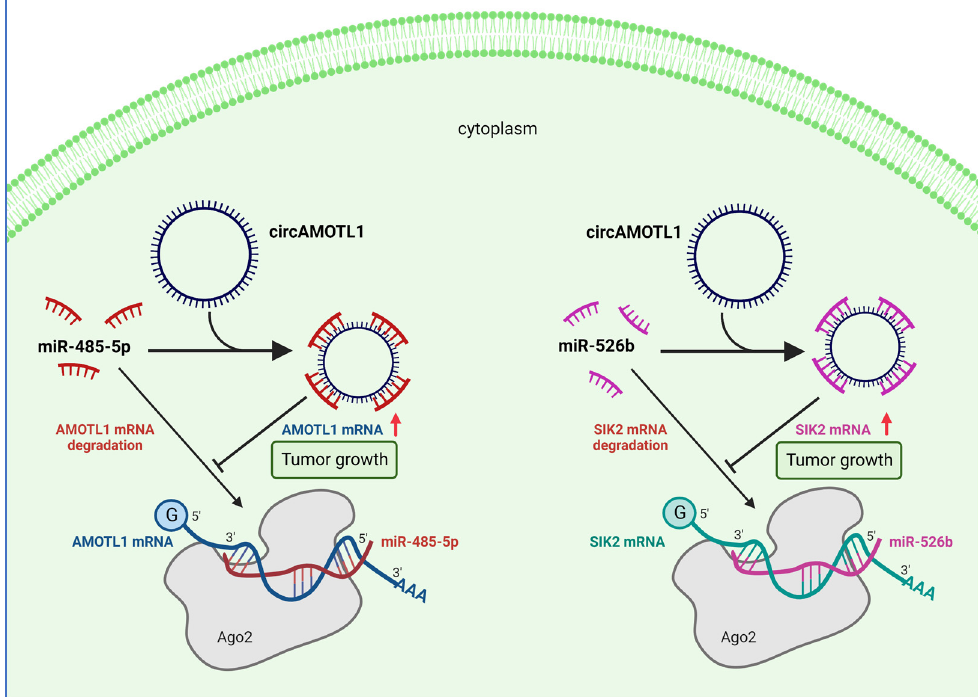
Figure 5. In cervical cancer cells, circAMOTL1 is concentrated in the cytoplasm, where it serves as a sponge that sequesters different miRNAs. miR-485-5p targets AMOTL1 mRNA, while miR-526b degrades SIK2 mRNA. CircAMOTL1, therefore, promotes cervical cancer progression by inhibiting miRNA-dependent degradation of oncogene mRNAs such as AMOTL1 and SIK2